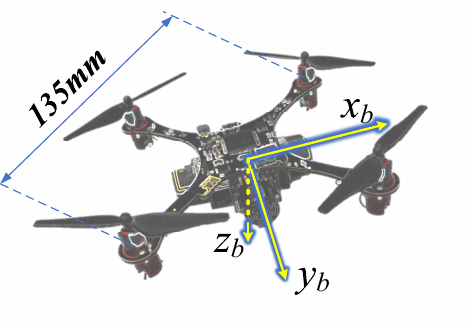
Figure 1. The Thales II micro air vehicle (MAV) platform with body frame axis orientation.